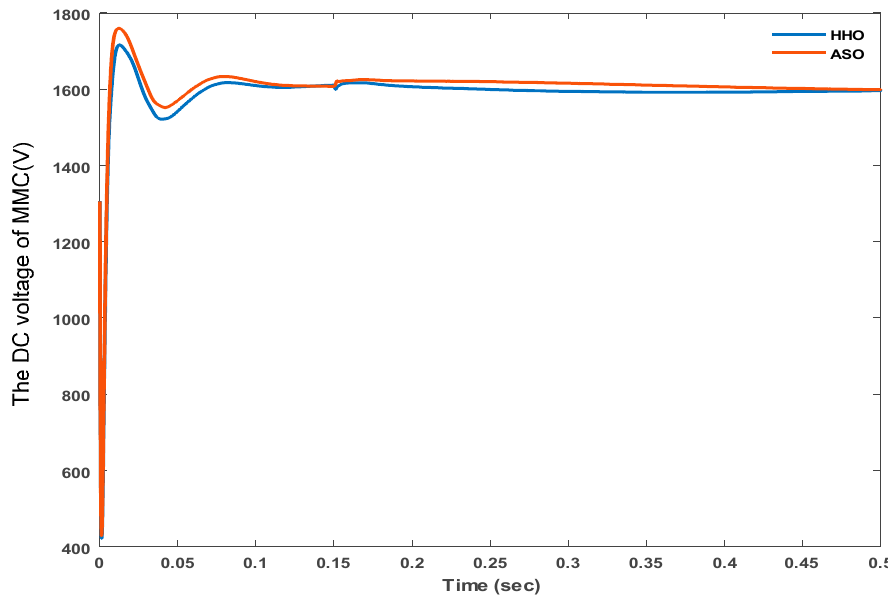
Figure 14. The DC voltage of the MMC using HHO and ASO.